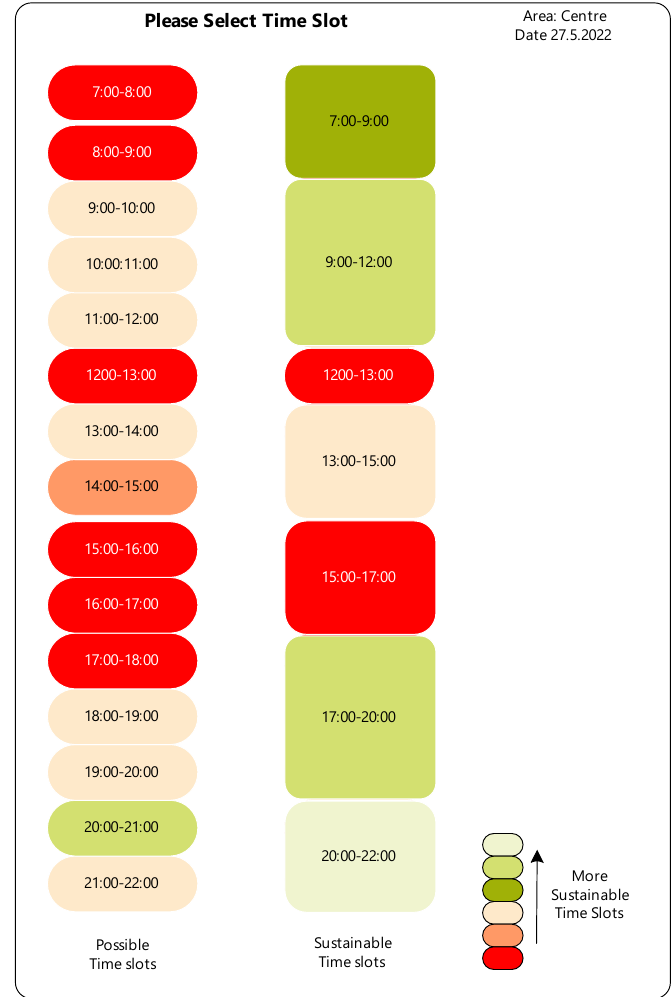
Figure 5. Time Slots Offer to Customer.